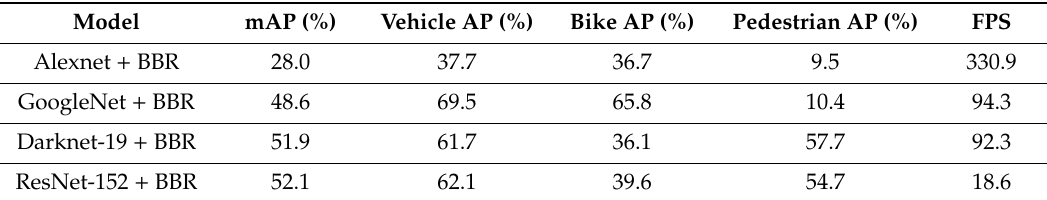
Table 4. The mean average precision (mAP) of di ff erent backbone layers.